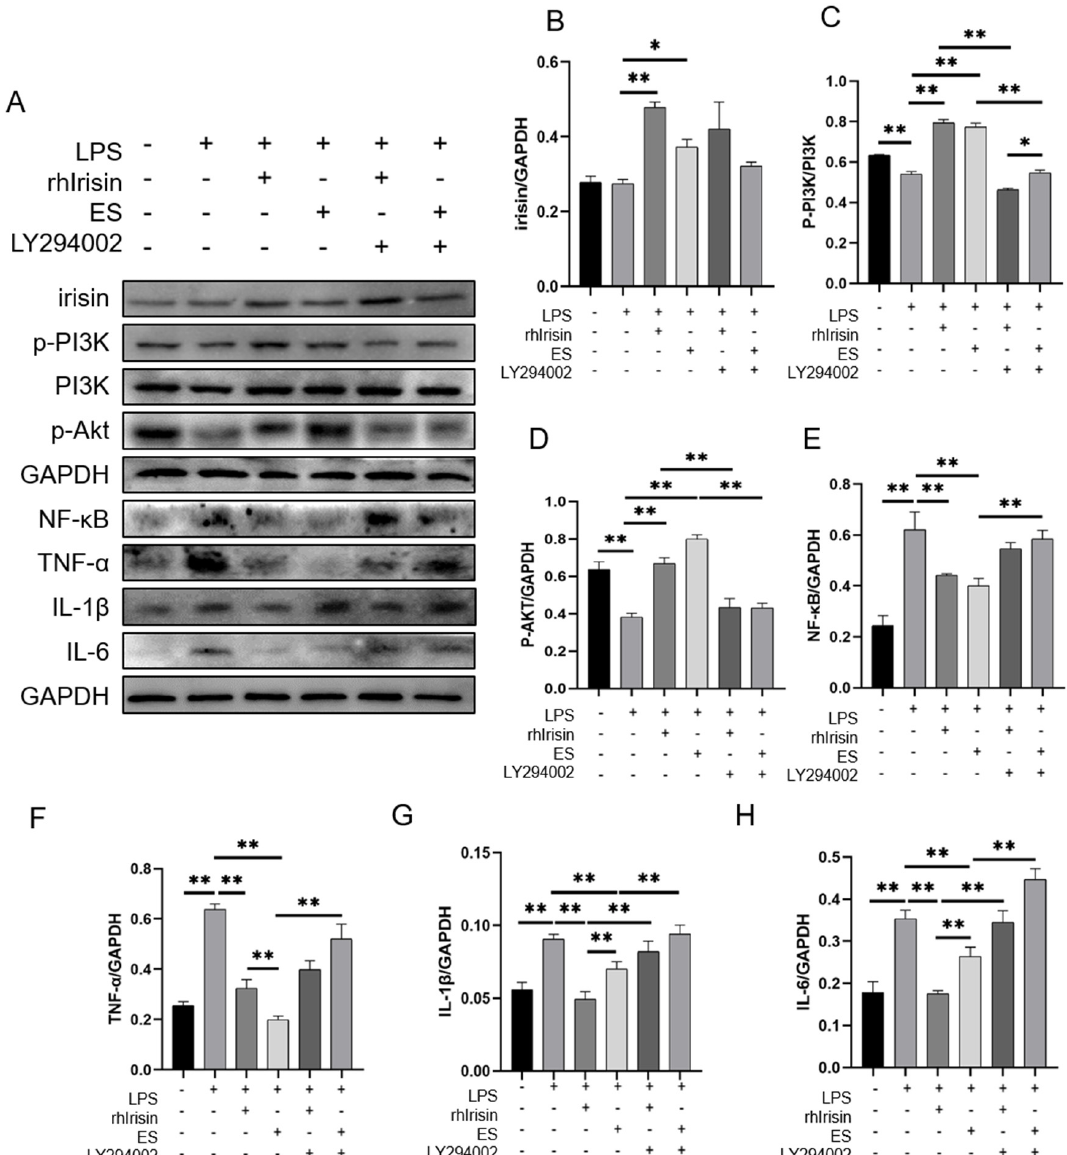
Figure 5. Irisin exerted anti-inflammatory effects through activation of the PI3K/Akt signaling pathway. ( A ), Western blotting results; ( B – H ), analysis of the expressions of inflammatory factors and signaling pathway proteins in primary mouse hepatocytes. Data are expressed as mean ± SEM, n = 3. * p < 0.05, ** p < 0.01 by one-way ANOVA.